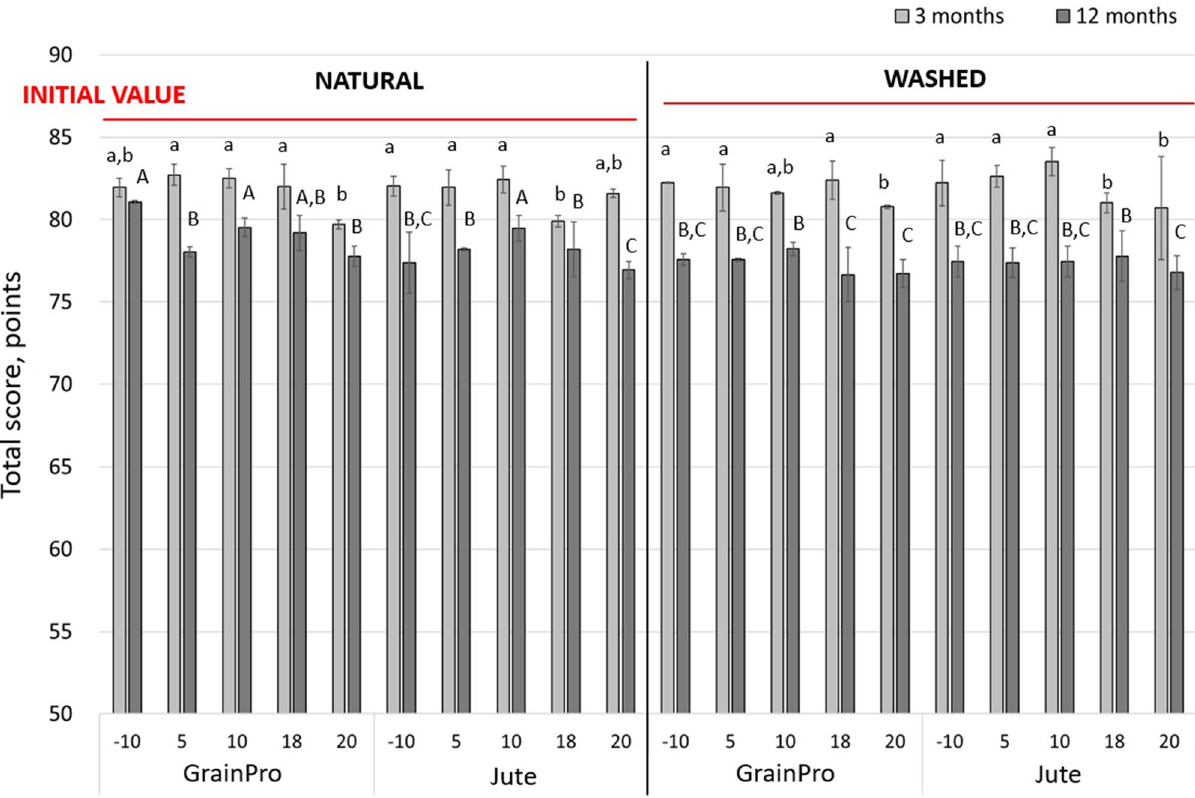
Figure 1. Comparison of the total scores for the coffee samples roasted from washed and natural processed green beans stored in GrainPro and jute bags for 3 and 12 months relative to the initial values before storage. The superscripts a and b denote significant ( p < 0.05) differences between the coffees stored in different bags and at different temperatures for 3 months. The superscripts A, B, C denote significant ( p < 0.05) differences between the coffees stored in different bags and at different temperatures for 12 months. Mean values ± standard deviation (n =